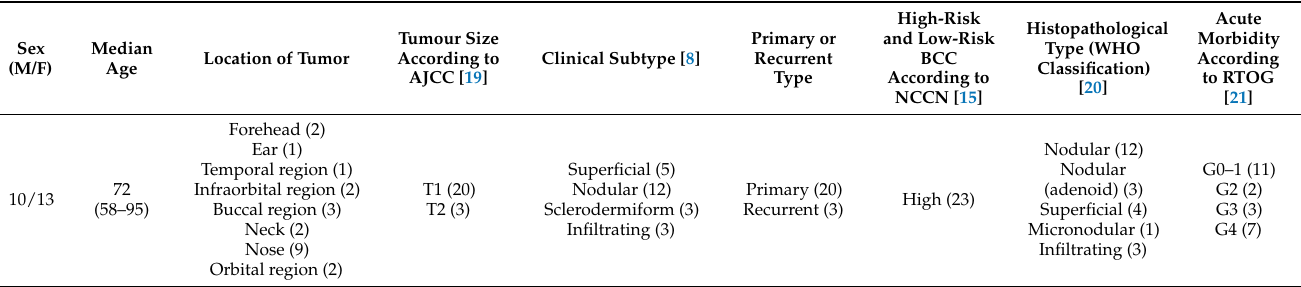
Table 1. Clinical, histopathological and therapeutic characteristics of observed patients’